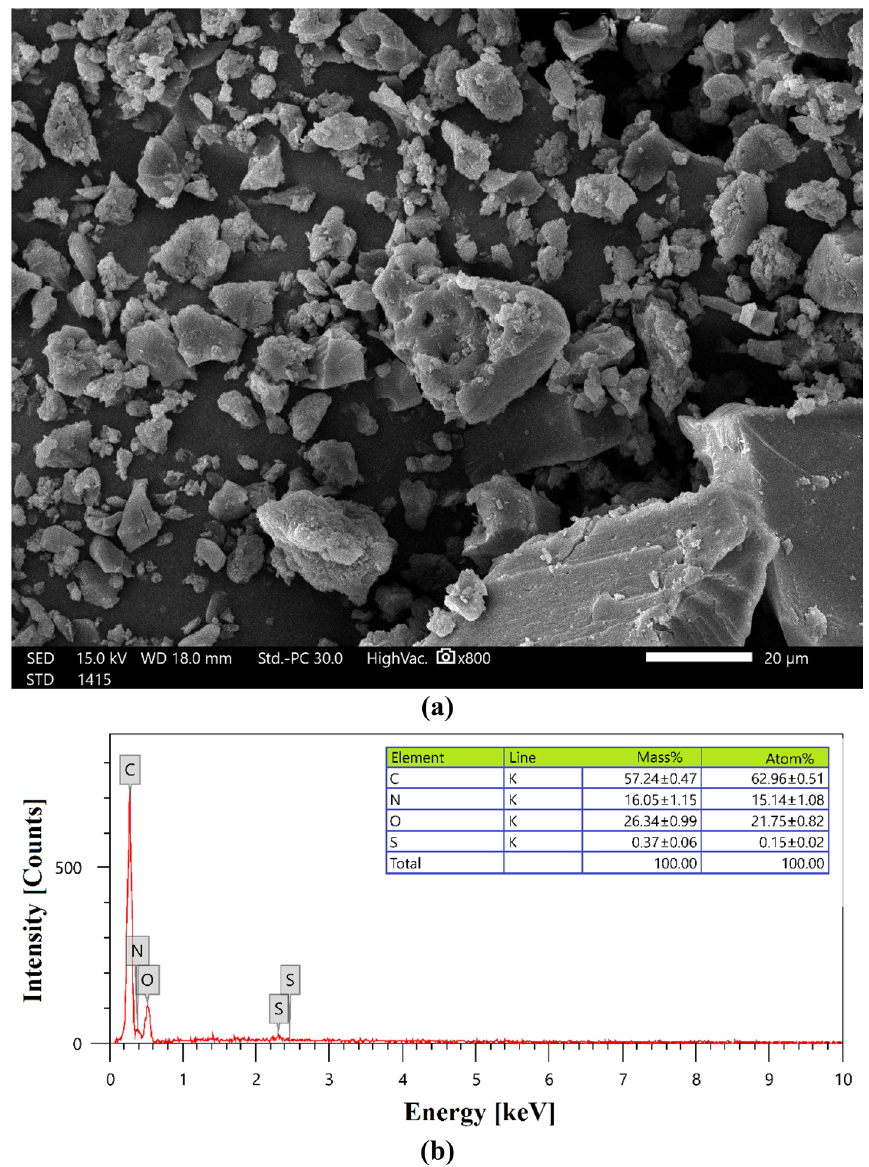
Figure 4. ( a ) SEM image of the MBT magnification at × 800 under high vacuum; ( b ) EDX analysis of MBT prepared from mandarin